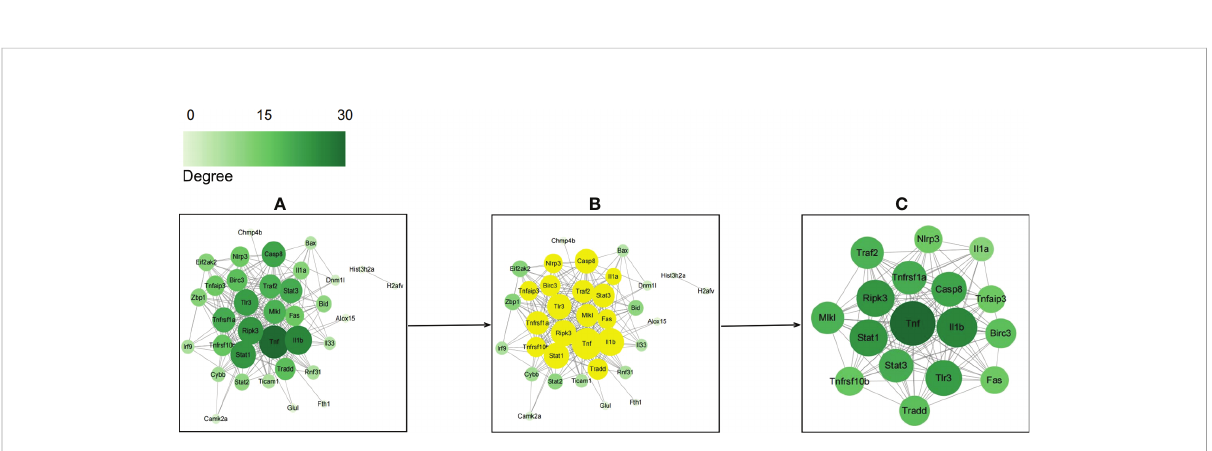
FIGURE 5 Protein-protein interaction networks of necroptosis-related differentially expressed genes (NRDEGs) based on STRING and Cytoscape database analyses. (A) PPI network of NRDEGs shows 218 edges and 35 nodes. (B) The top 17 hub NRDEGs based on CytoNCA. (C) The center of the NRDEGs shows 121 edges and 17 nodes.